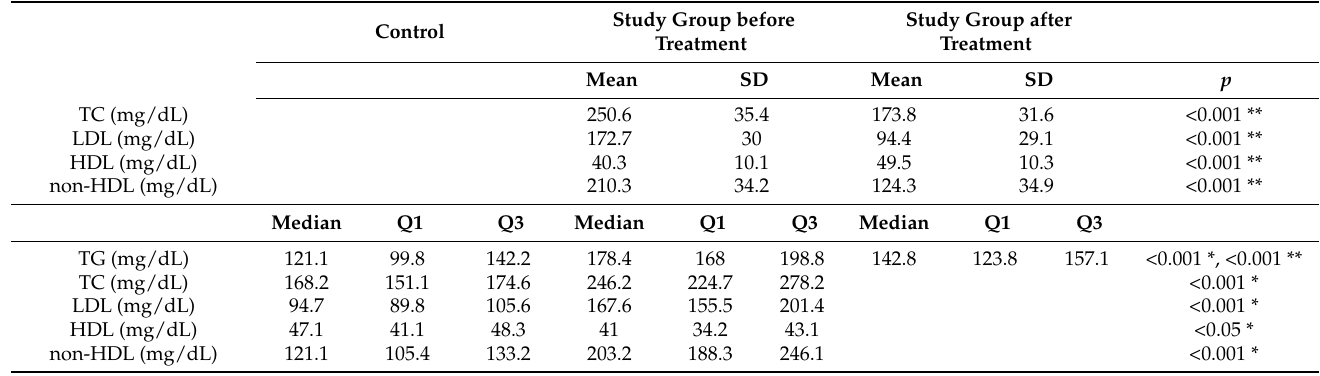
Table 2. Effect of alirocumab on plasma lipids. Control